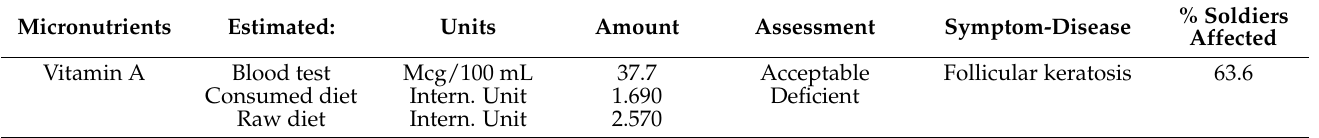
Table 11. Deficiency-related diseases and associated